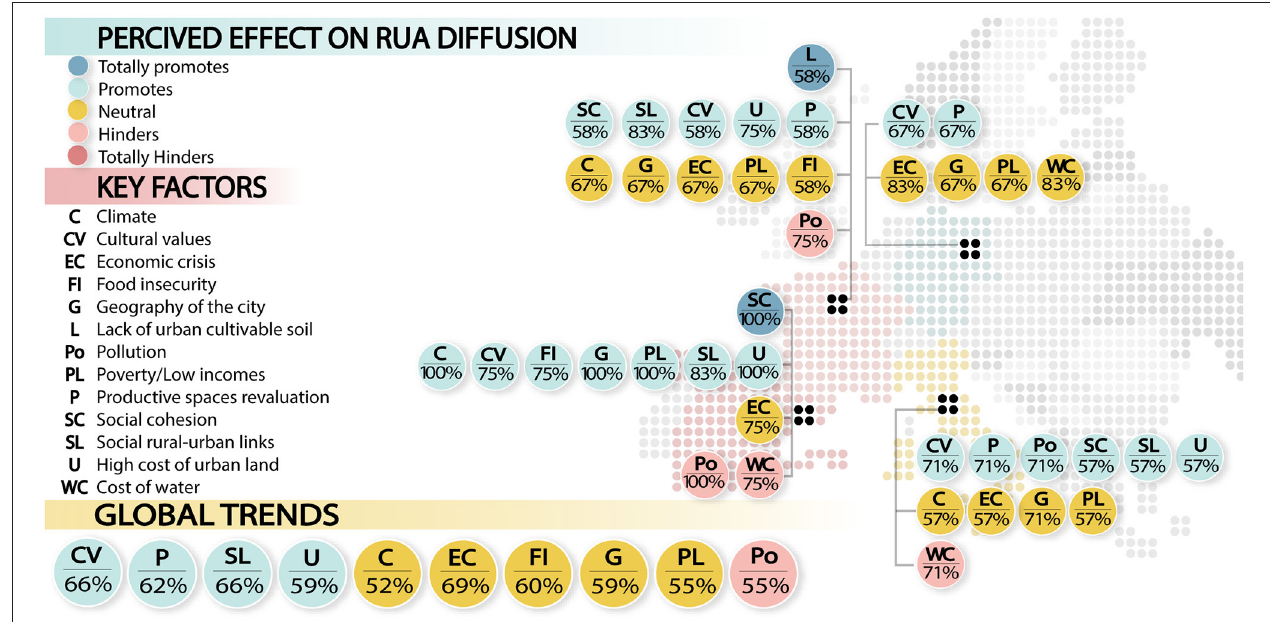
FIGURE 5 | Context factors and perceived effect on RUA diffusion in four European cities.